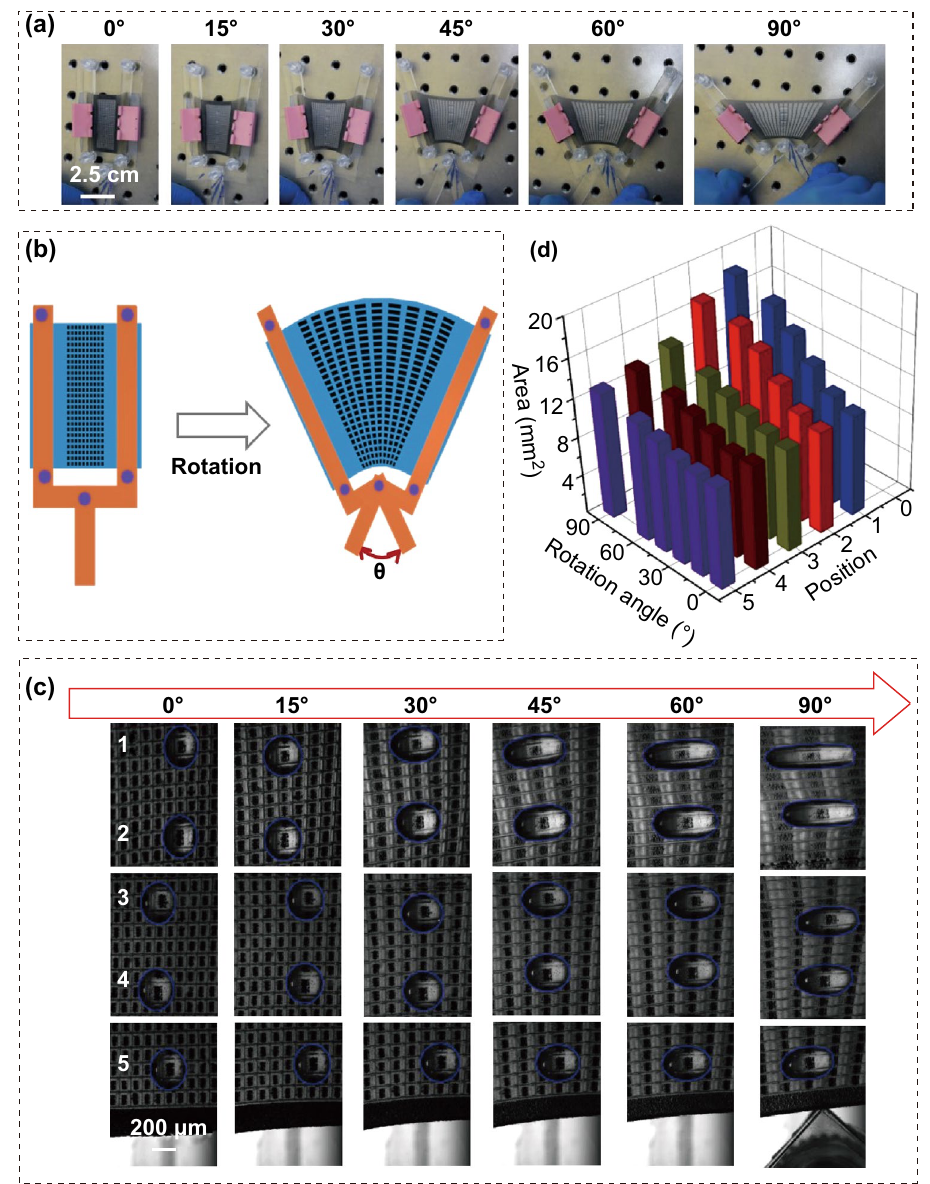
Fig. 4 a Photographs of the composite film subject to different angles created by a fixture. b Schematic diagram of the fixture in original and working states. c The bar graph of areas of the stretched water drop versus the applied angles at different positions marked as 1, 2, 3, 4, 5. d Pho‑ tographs of the water drop at different positions and different